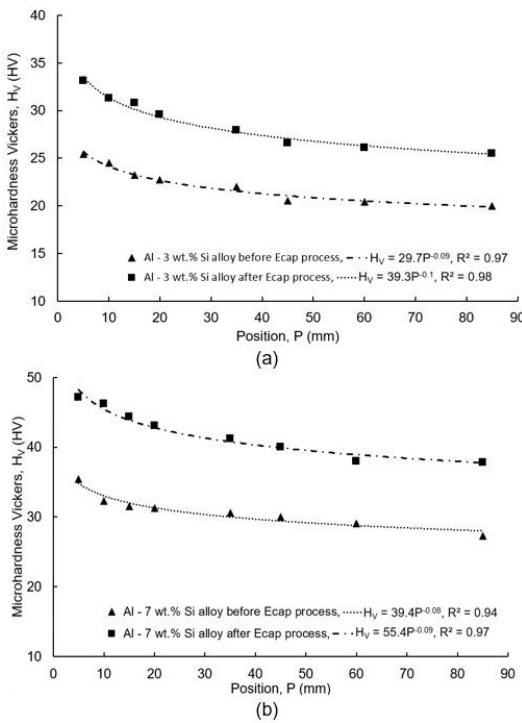
Figure 15. Measurements of microhardness ( H cooling rate (  T ): a) Al – 3 wt.% Si alloy, and b) Al – 7 wt.% Si alloy.